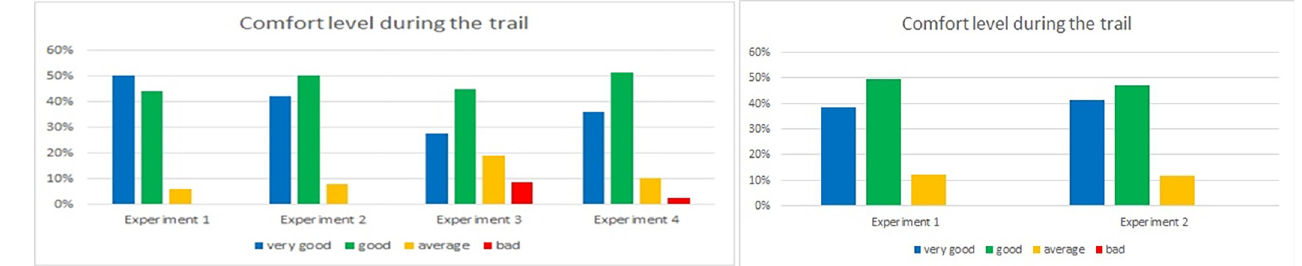
Fig 18. Participants’ comfort level—question 9. (Results from the Laliki experiment are on the left; results from Gda ń sk are on the right).